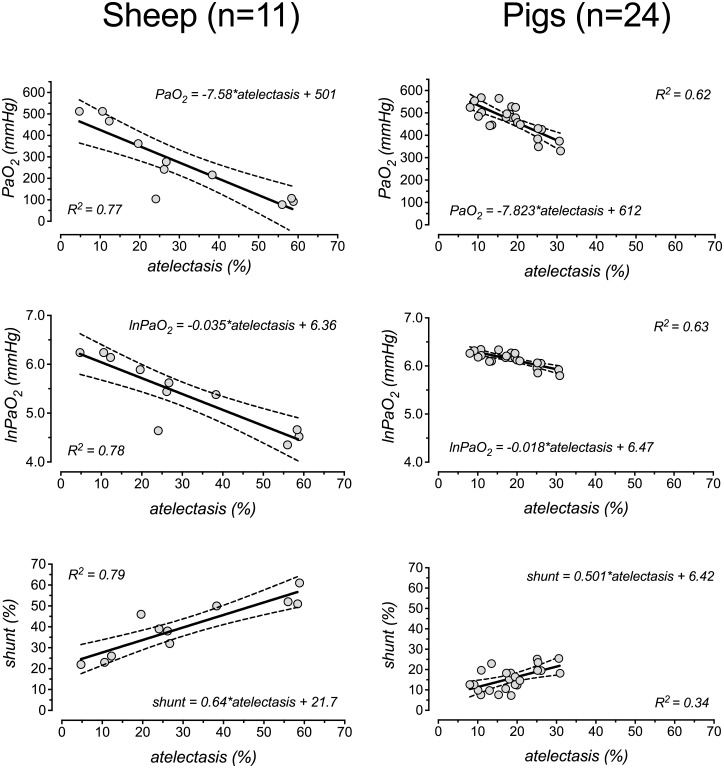
Correlation between atelectasis, oxygenation and shunt.Linear regression of raw PaO2 (upper row), ln-transformed PaO2 (lnPaO2, second row) and intrapulmonary (Bergren’s) shunt (lower row), respectively, on the amount of atelectasis (percentage of total lung mass). Only data points from the “atelectasis” columns in Table 1 were used. Berggren’s shunt was calculated according to [28]. We transformed PaO2 values logarithmically (lnPaO2) to linearize the relationship between PaO2 and atelectasis.